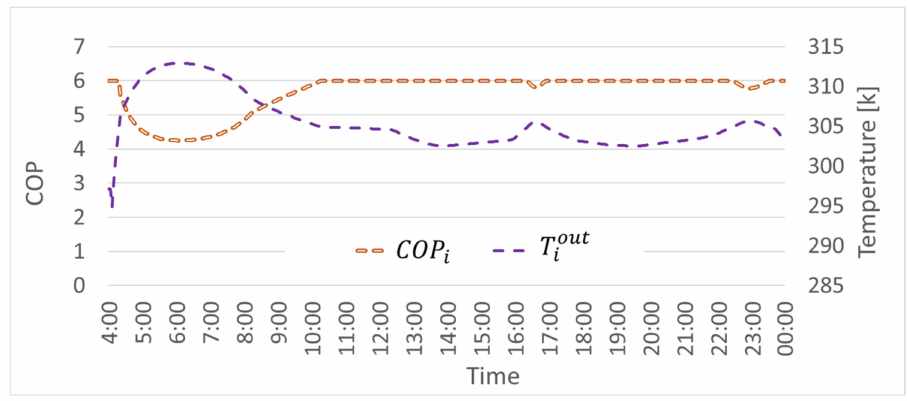
Figure 5. T out vs. COP i values in the MPC i